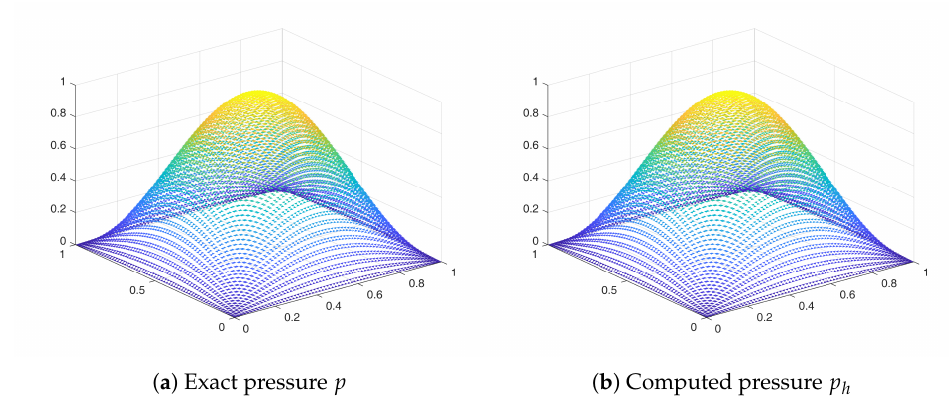
Figure 2. Exact and computed pressure for Example